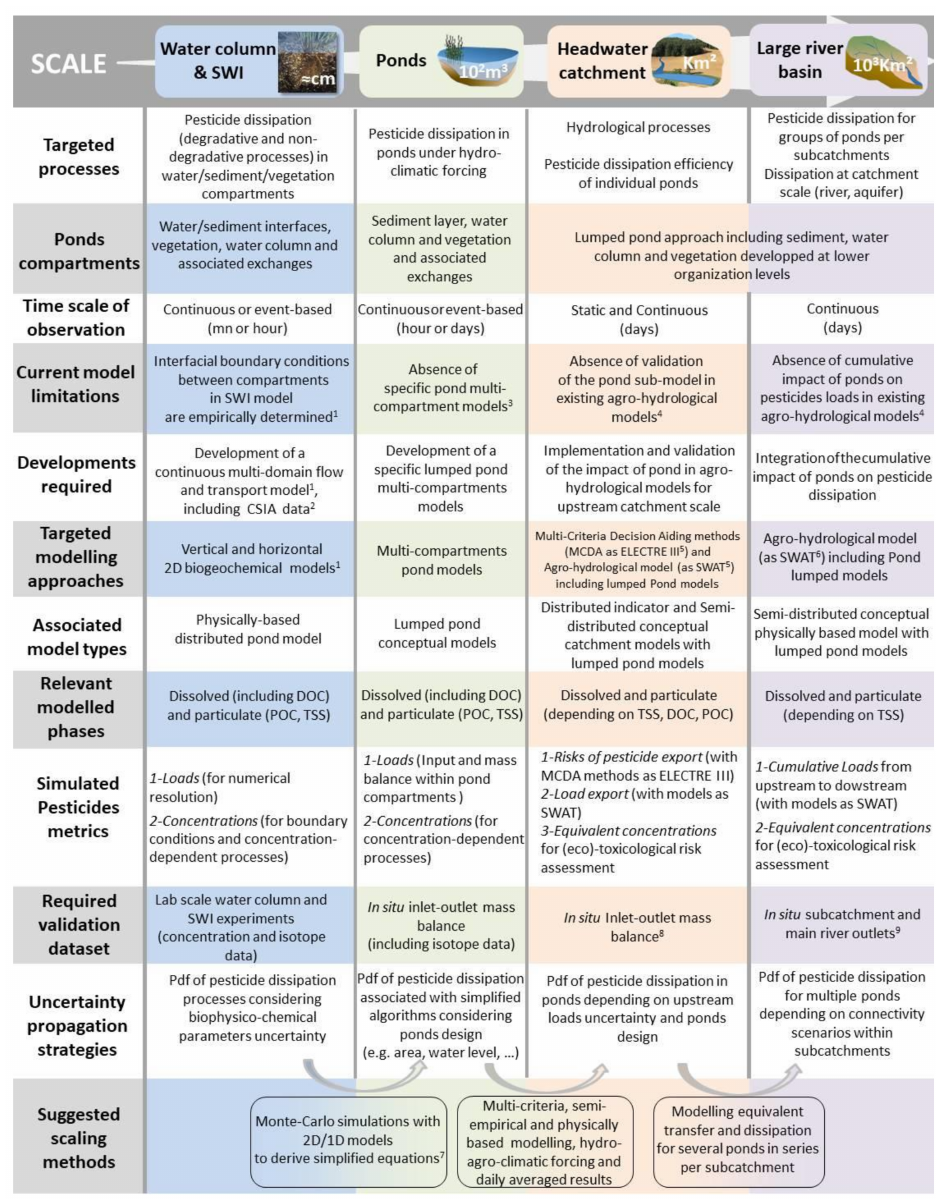
Figure 2. Modelling framework integrating the role of ponds to control pesticide transfer at the headwater catchment and the large river basin scales. The framework involves a modelling chain from pesticide dissipation within pond compartments up to pesticide transfer in river basins. Pdf: probability density function. 1 Based on Stokes-Darcy-Brinkman conceptualization [74]; 2 Reactive transport (e.g., [43]); 3 Multi-compartment models [72]; 4 Adapting the behavior of pesticide and ponds compartments in SWAT [75], with empirical relationships (0D modelling) derived from the results of the 2D models at the pond scale. The 0D modelling attributes a dissipation rate to each pesticide, depending on the measurable variables and the ponds’ characteristics and connectivity; 5 [76–78]. 6 [75]; 7 following the approach developed by [79]; 8 A detailed mass balance can be performed from the existing databases to identify the optimal formalisms and provide a diagnosis with existing data from upstream catchment and ponds. Datasets are obtained from the well-referred experimental sites of the PESTIPOND project (Figure S1 and Table S1 of the Supplementary Materials). The PESTIPOND experimental sites belong to the RI-OZCAR (Research Infrastructure—Critical Zone Observatories: Research and Application [80]), the RECOTOX network (Research initiative in toxicology/ecotoxicology [81]), the RI-RZA (LTSER Zones Ateliers network [82]), and/or the European RI-eLTER (European Long-Term Ecosystem Research). 9 Monitored river-basin such as the Save (Site of the LTSER Zone Atelier Pyr é n é es-Garonne, Gascony, 1100 km 2 ) [77,83,84] can support the development and the validation of the last upscaling step of impact of ponds from the headwater catchments to the large river